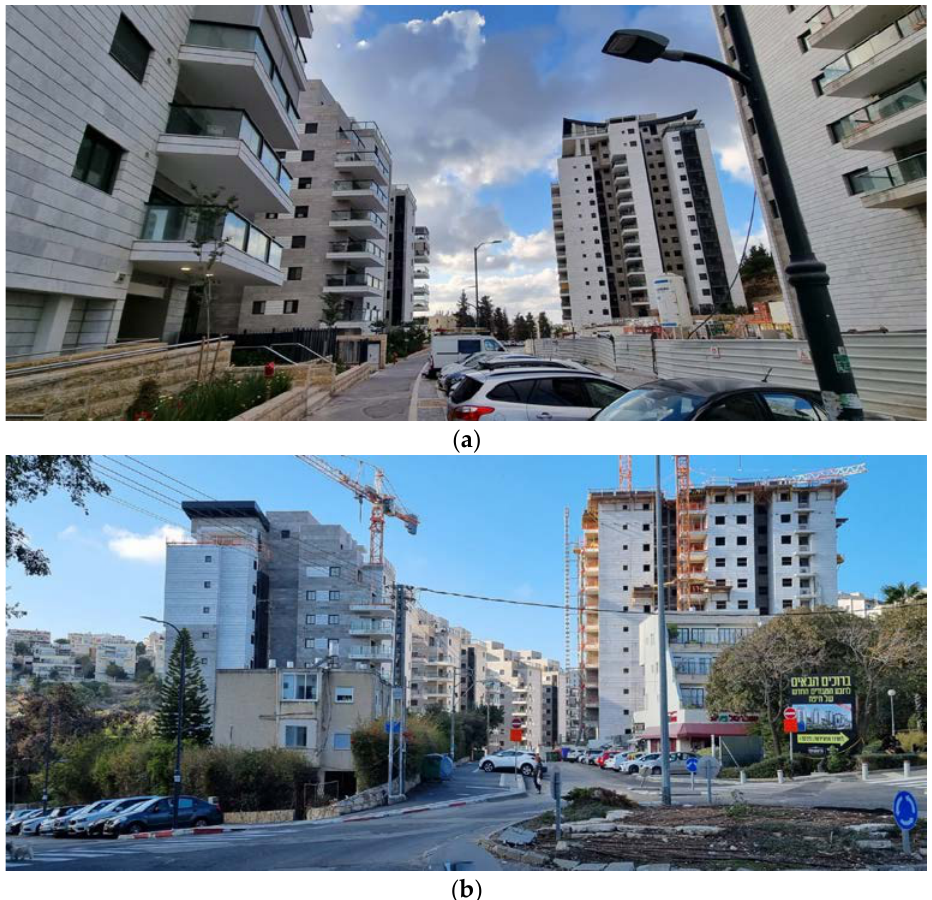
Figure 3. Berl-Katzenelson Site. A view from the inner side of the site ( a ); A view from the entrance to the site ( b ). Photographed by the author,